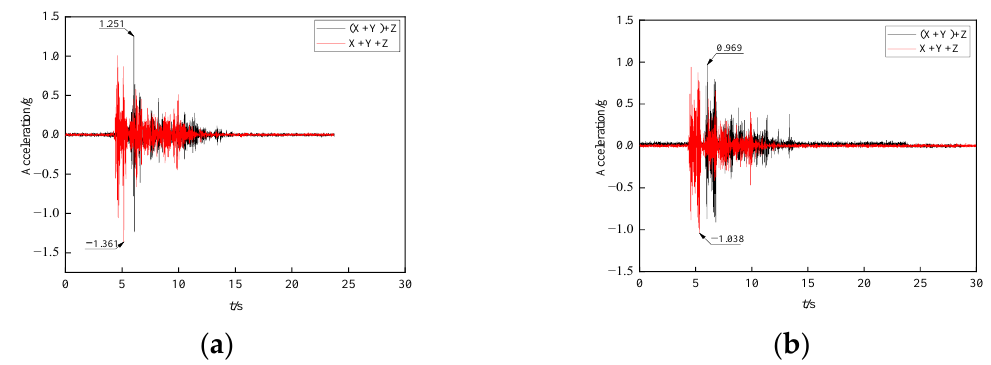
Figure 8. Vertical acceleration response at the mid-span. ( a ) Beam 1; ( b ) Beam 3.